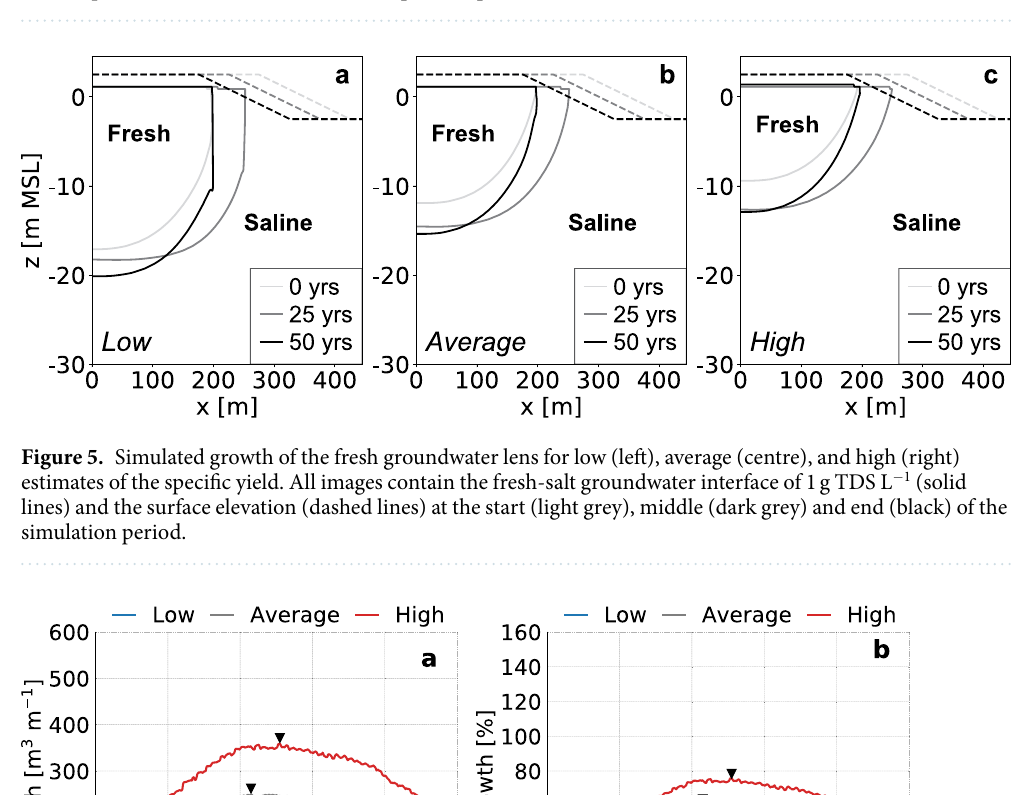
tidal range. Sites with intermediate tidal ranges attain the largest fresh groundwater lens (Fig. 9b) and high- est absolute growth during the simulation period (Fig. 10a). This is a result of two counteracting processes that are related to the increase in (net) seawater intrusion for sites with larger tidal ranges. Increases in the infiltration